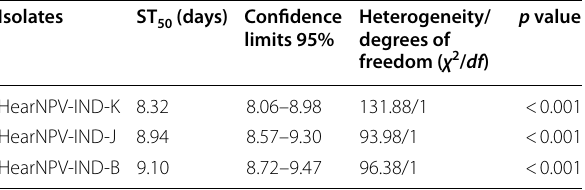
Table 2 Time response bioassays of three different HearNPV isolates against Helicoverpa armigera larvae at their respective median lethal concentrations